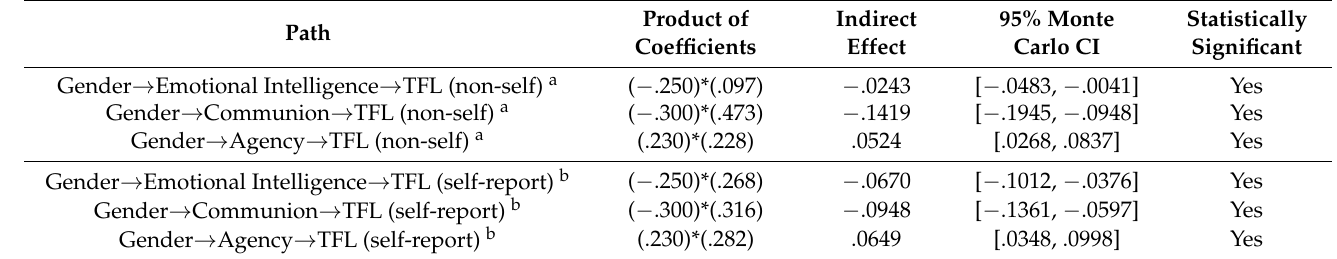
Table 7. Test of indirect effects for gender and transformational leadership (non-self-reported TFL and self-reported